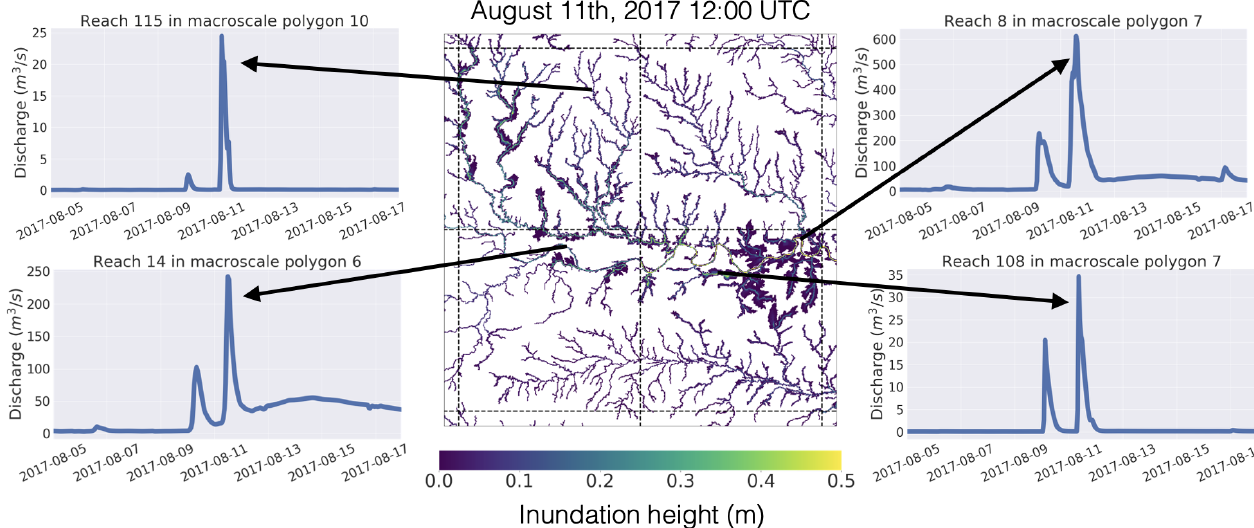
Figure 5. The center panel shows the simulated inundated height over the four central macroscale polygons in the study domain on 11 Au- gust 2017 at 12:00UTC. The remaining four plots show the simulated discharge at four different reaches between 5 and 17 August. The arrows point to the time step on each time series that correspond to the mapped inundation height. Note that mapped inundation height is upscaled to a 100m spatial resolution for visual clarity.